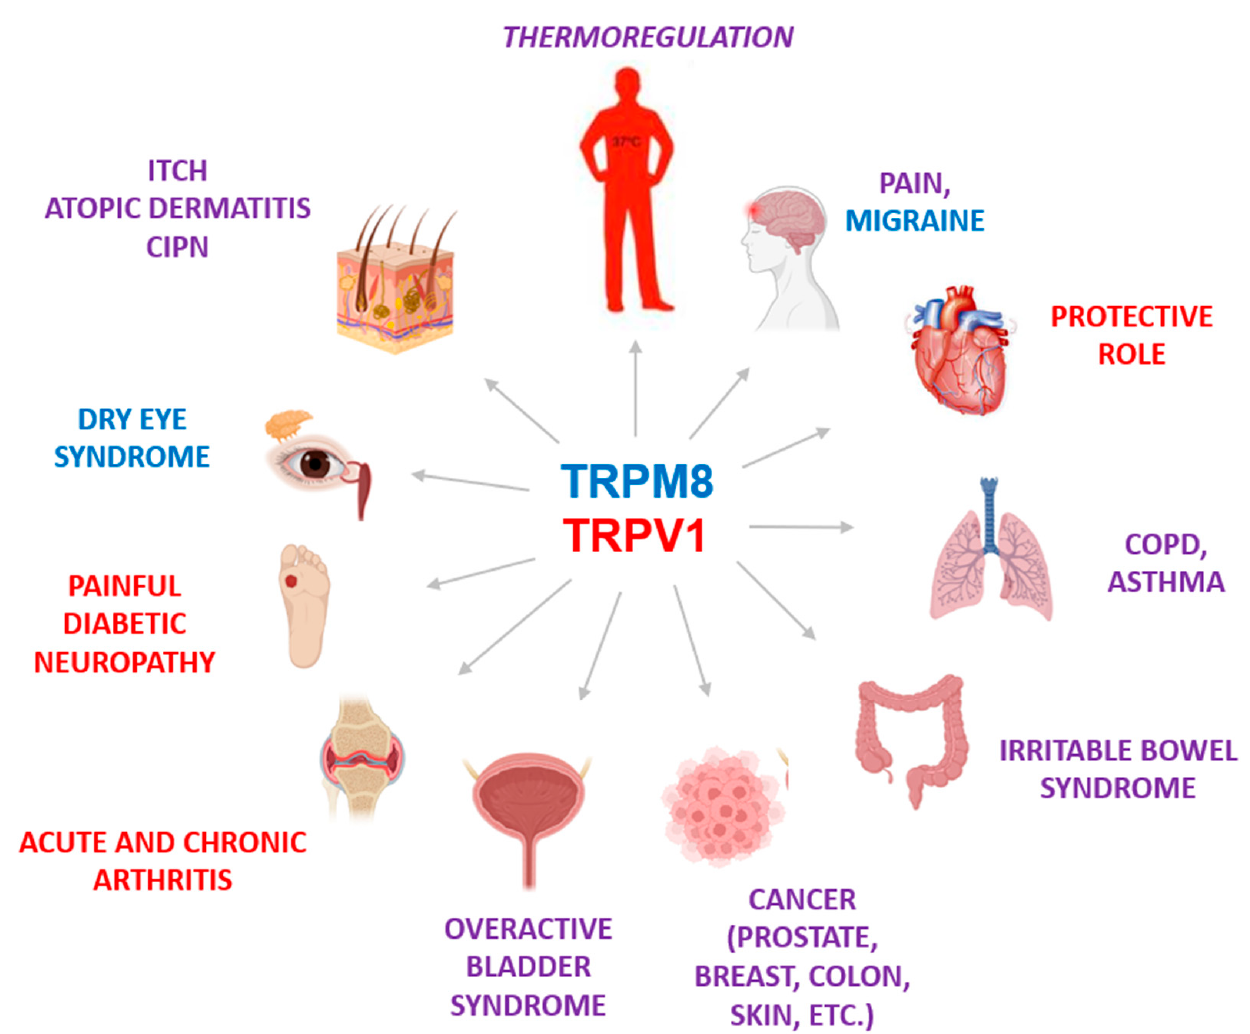
Figure 1. Pathological and physiological roles of TRPV1 and TRPM8. In addition to being temperature sensors, both channels are involved in many physiological functions in different organs. Therefore, alteration of their function leads to several pathologies. The figure shows some of the diseases caused by alteration of the function of TRPM8 (blue) and TRPV1 (red) or some pathologies in which both channels have been implicated (purple).